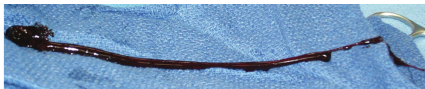
Figure 3: Large blood clot removed from the left iliofemoral artery intraoperatively. CTA of bilateral lower extremities. White arrow points to filling defect of left external iliac